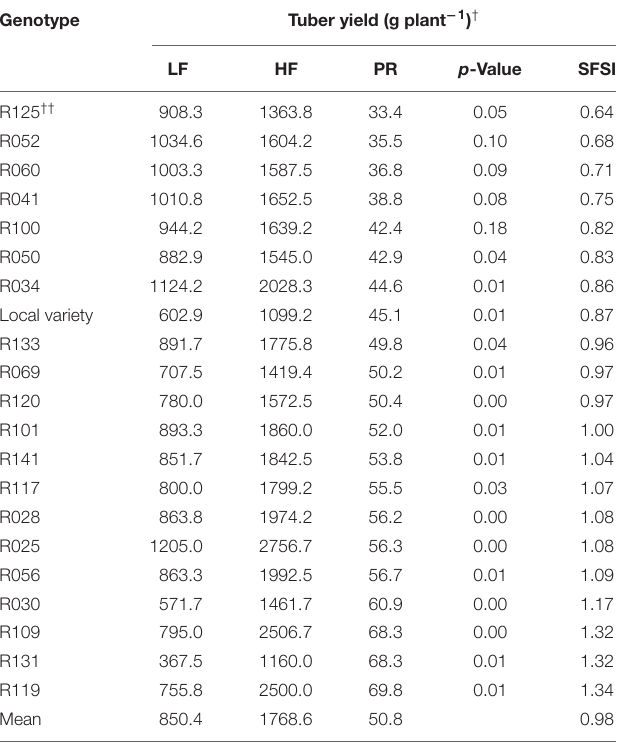
TABLE 3 | Effect of genotype and soil fertility on tuber yield (gram per plant) in 21 white Guinea yam genotypes.